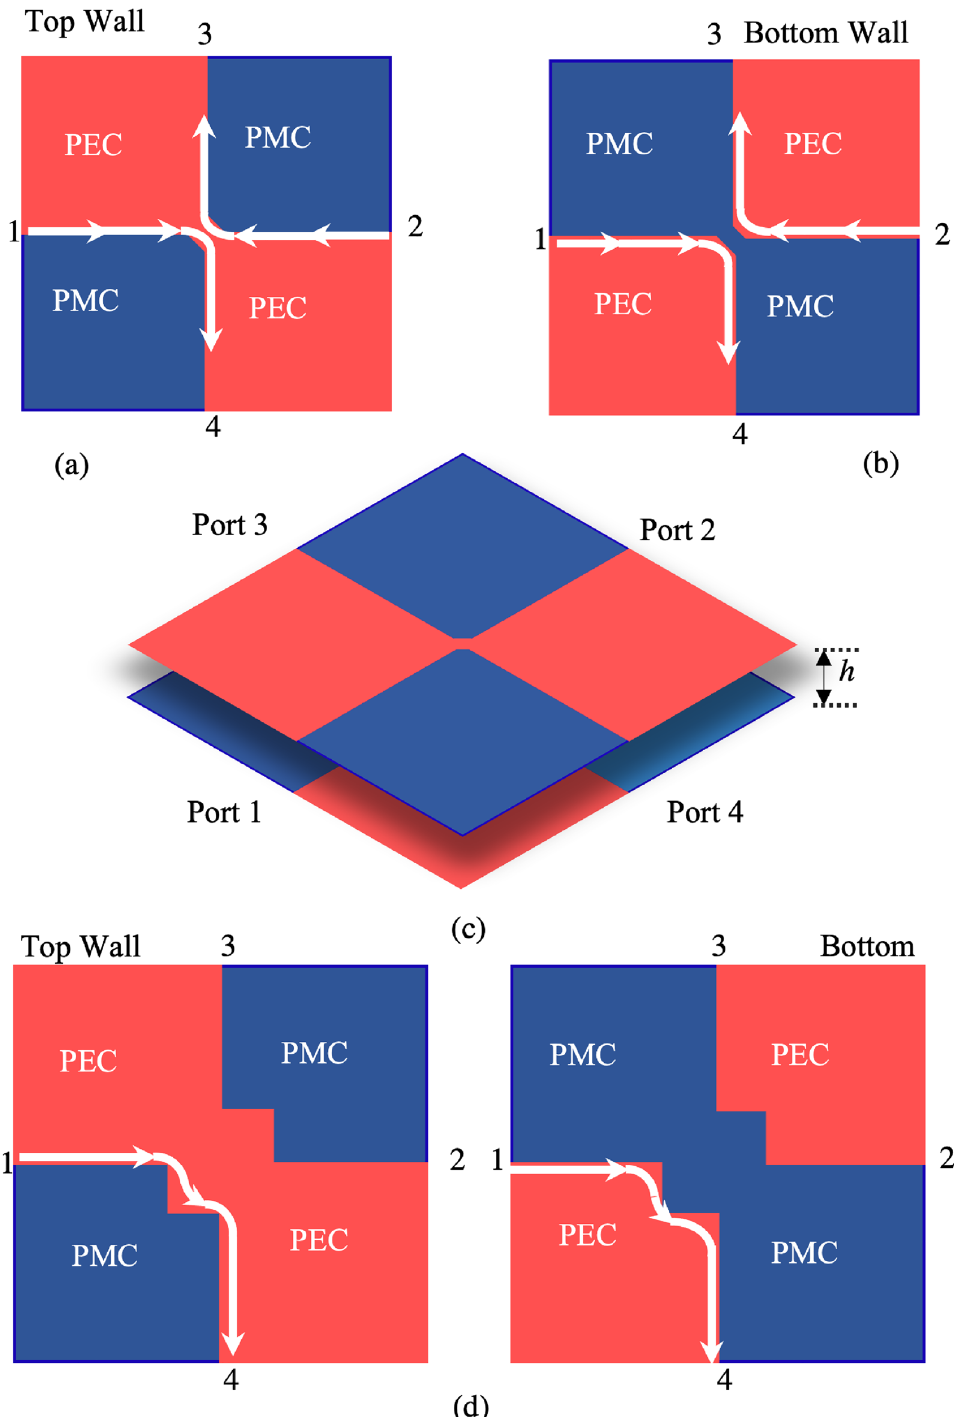
Figure 1. Ideal 4-ports coupler composed by a parallel plate with four alternating PEC/PMC squares on top ( a ) and dual wall on the bottom ( b ). A small bridge at the central connection maintains the PTD-symmetry of the device with respect to the orthogonal axis.( c ) Three dimensional view of the coupler. ( d ) Alternative geometry with a larger central